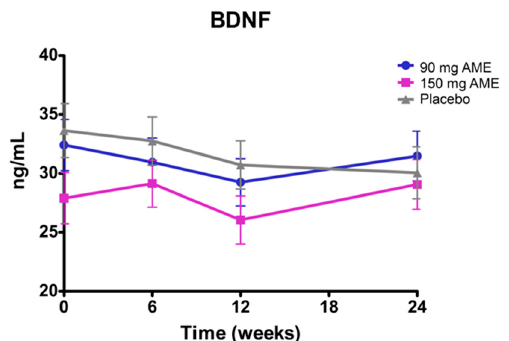
Figure 4. The effect of Aronia melanocarpa extract (AME) supplementation on BDNF levels in serum. Data are presented as actual mean ± SEM. Analysis was performed with a linear mixed model using estimated means, with correction for baseline values. BDNF: brain-derived neurotrophic factor.